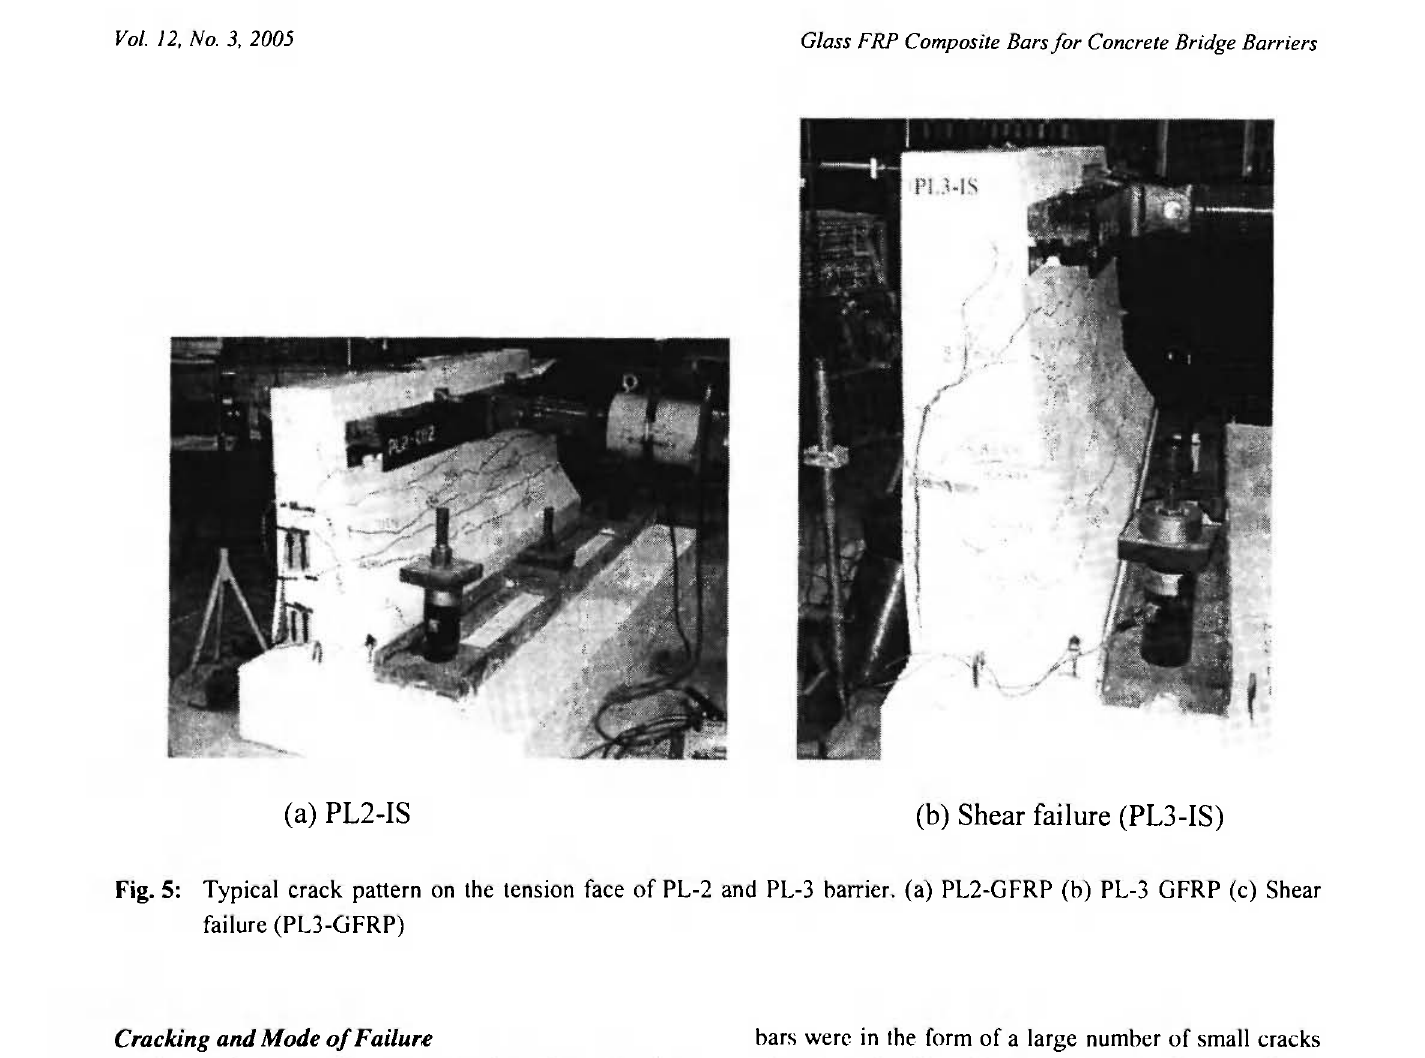
Fig. 5: Typical crack pattern on the tension face of PL-2 and PL-3 barrier, (a) PL2-GFRP (b) PL-3 GFRP (c) Shear failure (PL3-GFRP)